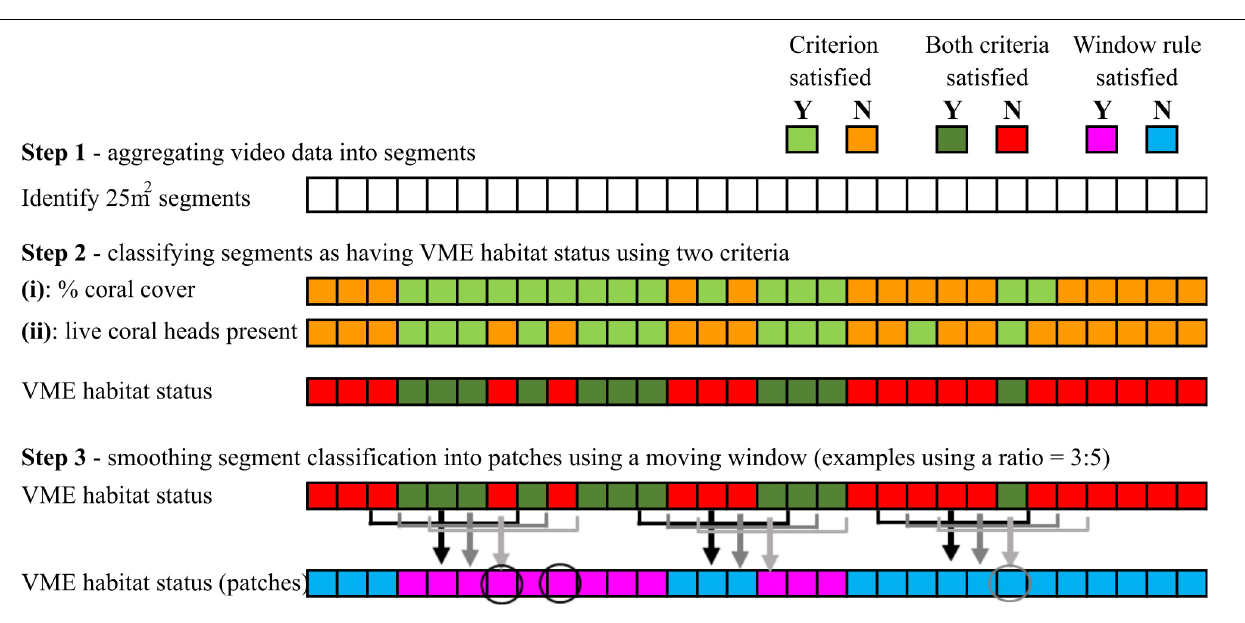
FIGURE 4 | Schematic illustration of how VME habitat status is classified at segment scale (steps 1 and 2), and the use of a moving window to aggregate segments into patches by smoothing (step 3). In the example shown here, the smoothing rule for the moving window is for a ratio of ≥ 3 of 5 segments inside the window to have VME habitat status. Where the rule is satisfied, the window attributes VME habitat status to the single segment in the center of the window as it moves along the transect. Circles show examples of how smoothing may result in